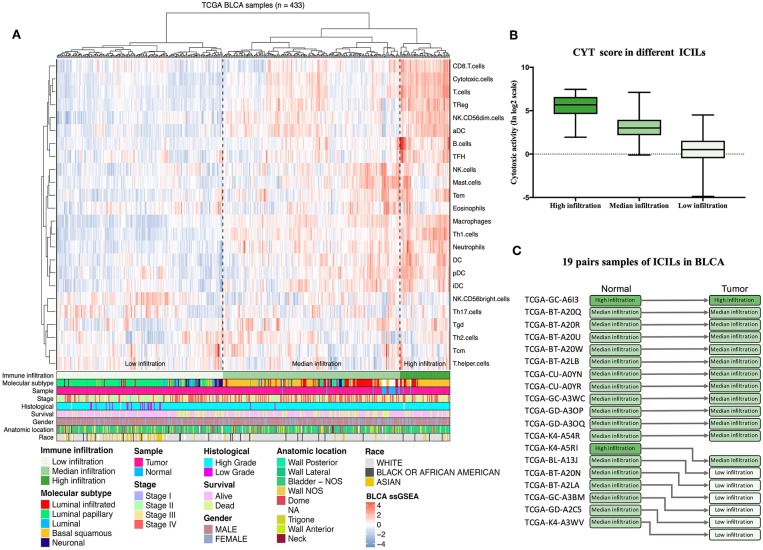
Immune infiltration landscape of BLCA. (A) Unsupervised clustering of 408 patients from The Cancer Genome Atlas cohort using single-sample gene set enrichment analysis scores from 24 immune cell types. Molecular subtype, sample type, stage, histological, survival, gender, anatomic location, and race are shown in the lower panel. Hierarchical clustering was performed with Euclidean distance and Ward linkage analyses. Three distinct immune infiltration clusters, termed high infiltration, moderate infiltration, and low infiltration, were defined. (B) Relative cytolytic scores (CYT scores) for tumors with high, moderate, and low immune infiltration were clustered according to overall immune cell infiltration. Kruskal–Wallis tests were used for analyses, and results with P-values of < 0.0001 were considered significant. Error bars represent the medians, interquartile ranges, and minimum to maximum values. (C) The evolution of immune infiltration levels in 19 cases with paracancerous tissues.